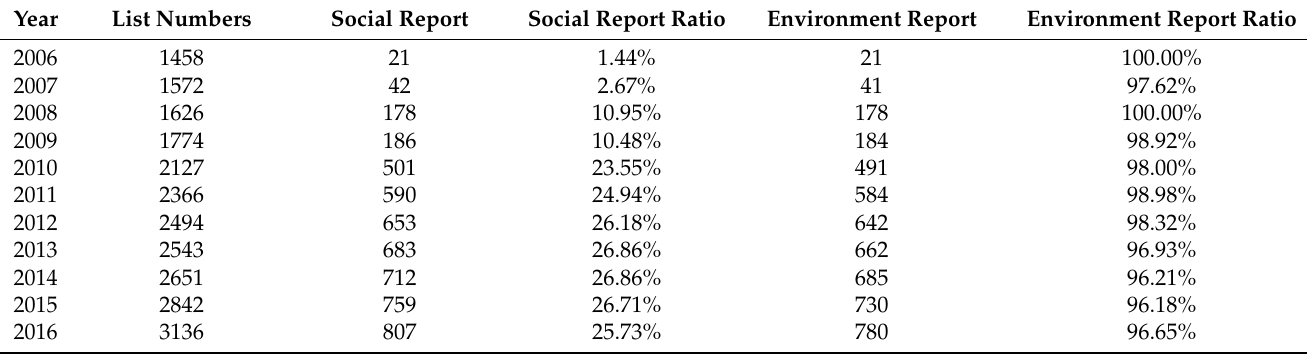
Table 1. CSR disclosure and environmental